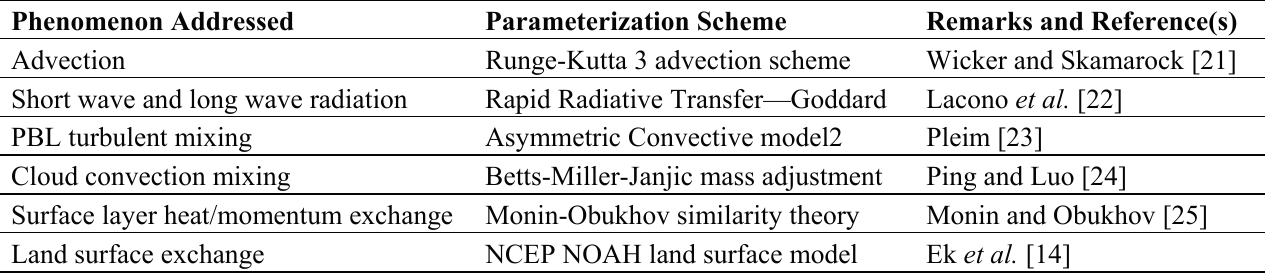
Table 1. Physics packages configured for the WRF-ARW component of